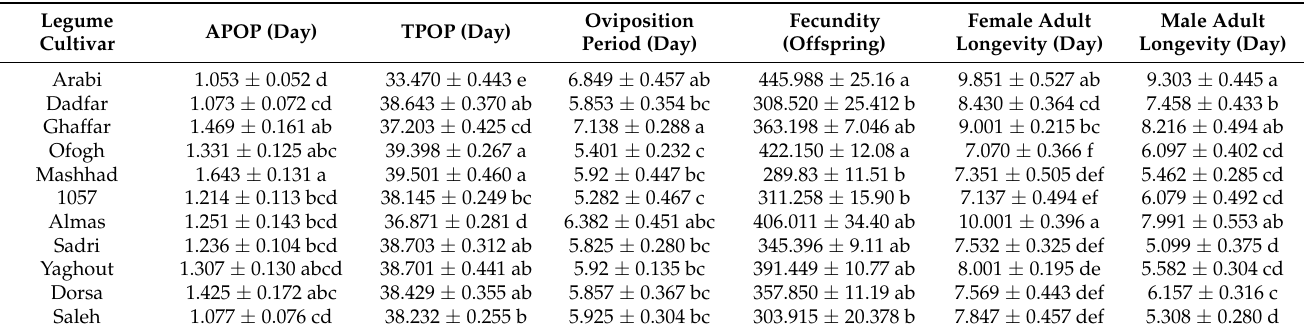
Table 2. The reproductive period, fecundity, and adult longevity (mean ± SE) of Spodoptera littoralis reared on various legume cultivars.